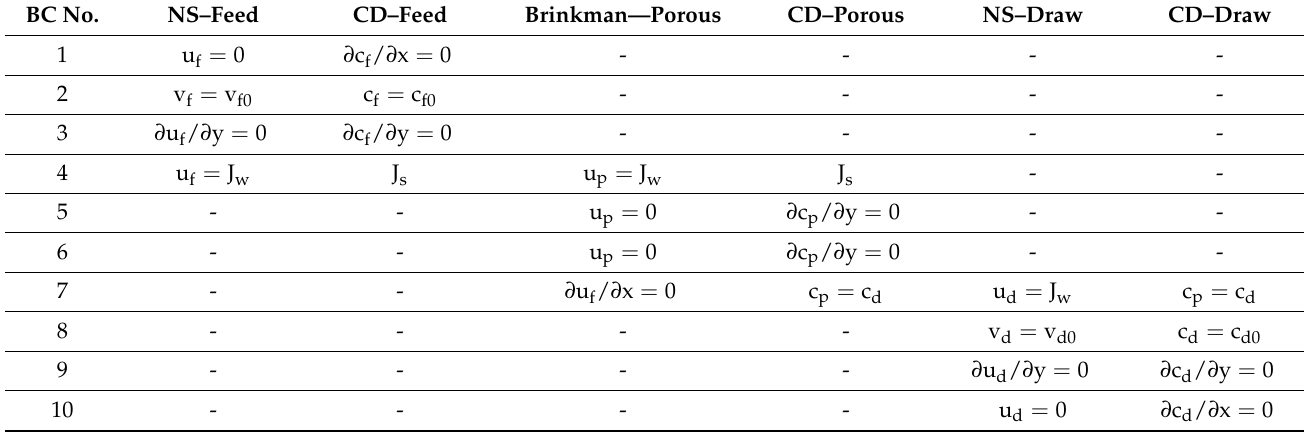
Table 2. Boundary conditions for the FO operation at FO